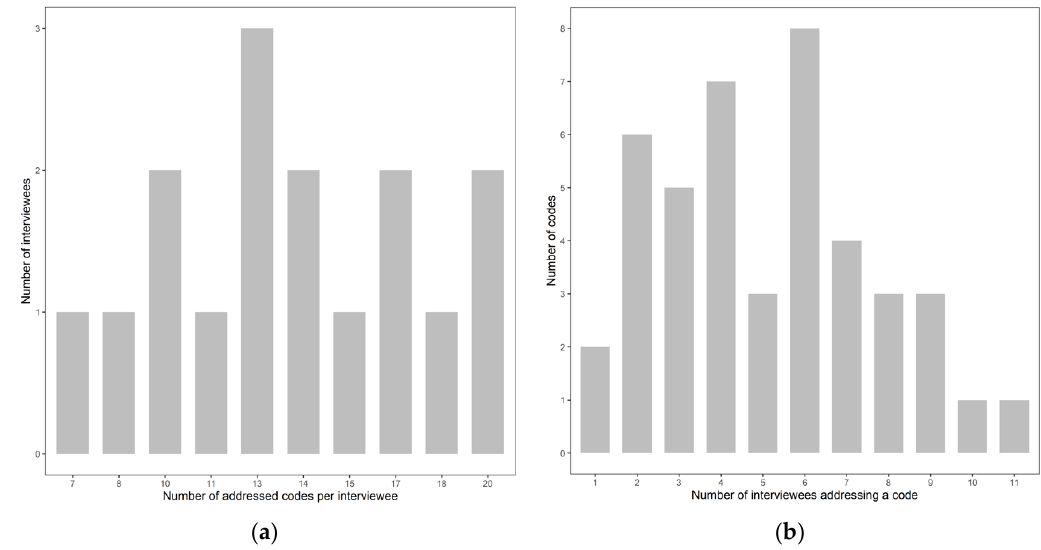
Figure 2. Degree distribution showing ( a ) the number of addressed codes per interviewee ( x -axis) and the number of interviewees addressing this specific number of codes ( y -axis) and ( b ) the number of interviewees addressing a code ( x -axis) and the number of codes addressed by this specific number of interviewees ( y -axis).